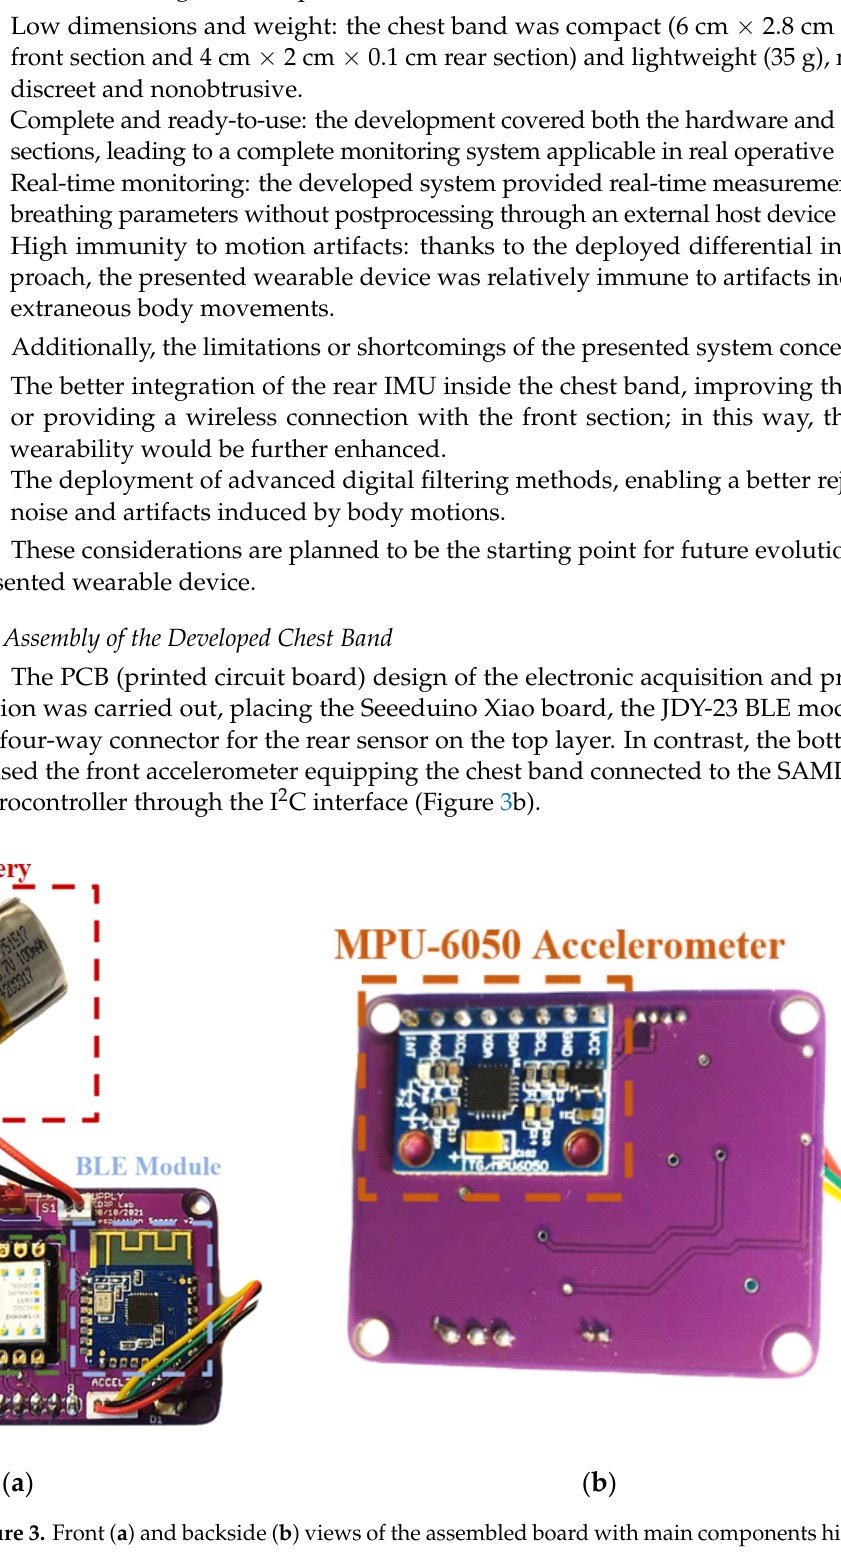
( b ) Figure 4. Pictures of the developed chest band: top view ( a ) of the electronic acquisition and pro- cessing section; rear ( b ) IMU mounted on proper support. 2.3. Firmware of Developed Inertia-Based Chest Band This section describes the working modalities and firmware development of the proposed wearable device, managed and controlled using a core section represented by the Seeeduino Xiao microcontroller board.